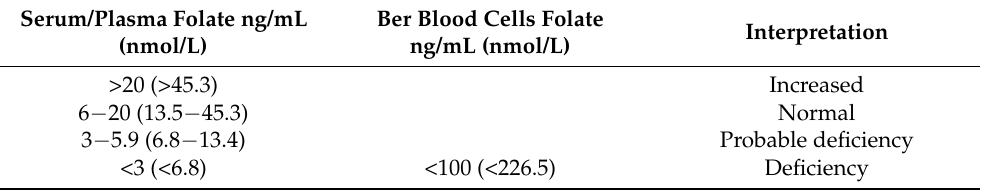
Table 3. Determination of folate status using macrocytic anemia as hematologic indicator [150,173]. Serum/Plasma Folate ng/mL